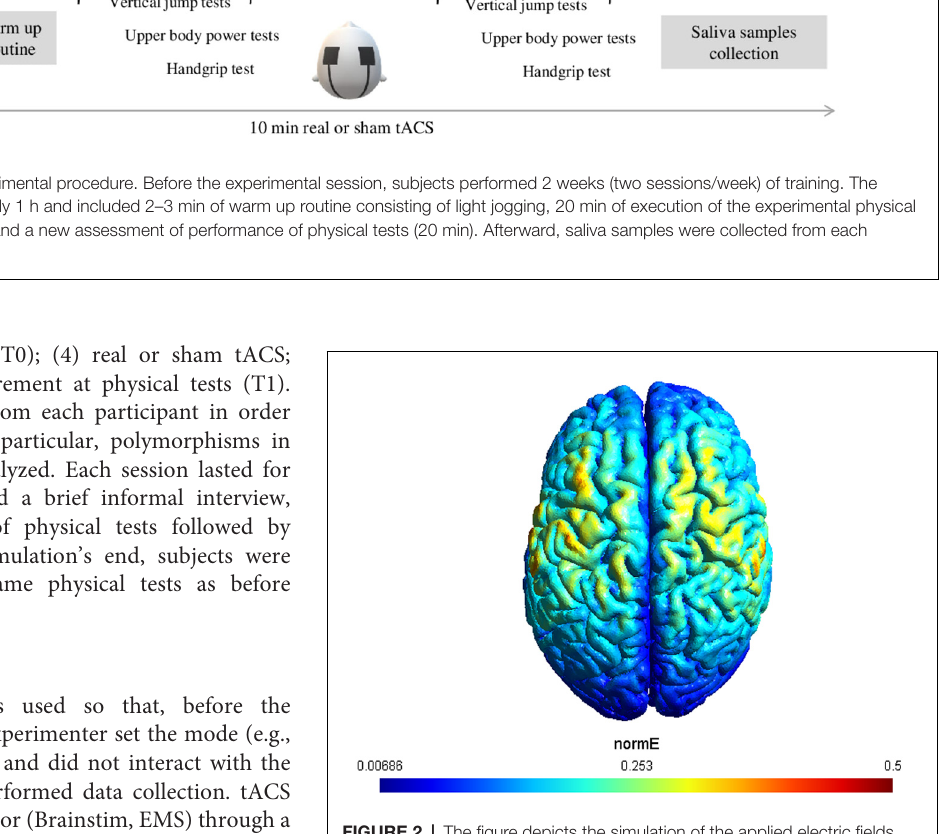
FIGURE 2 | The figure depicts the simulation of the applied electric fields. Electrodes were placed over C3 and C4, respectively. The maximum